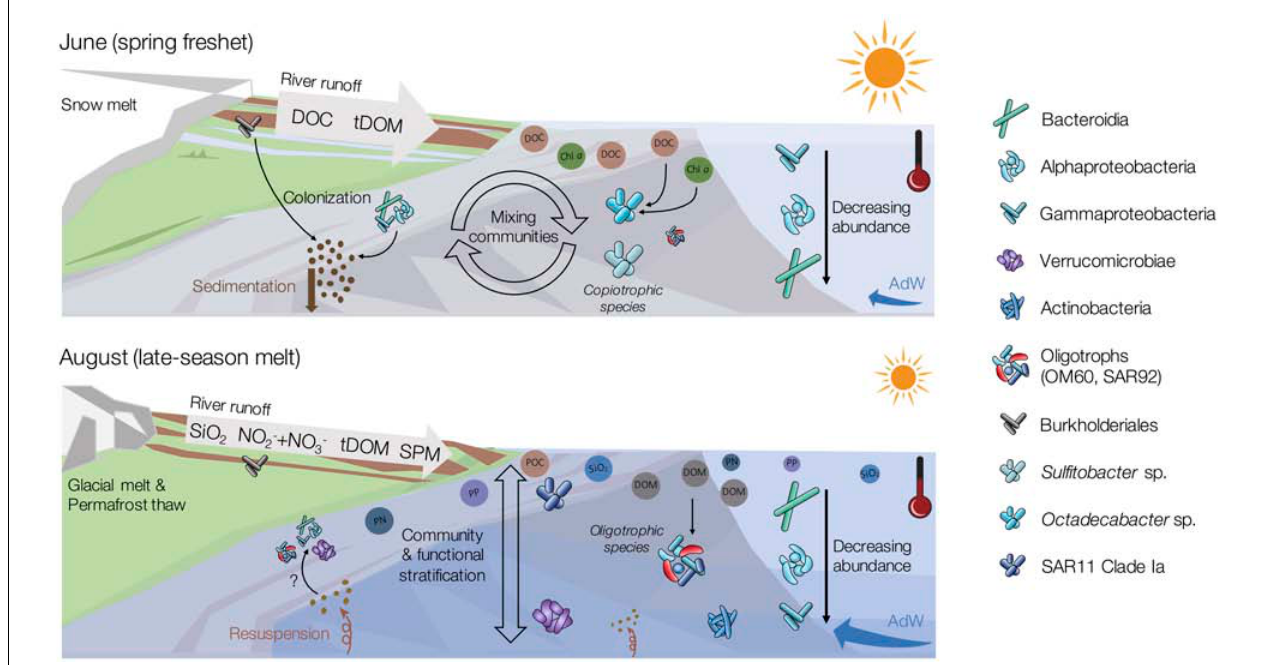
FIGURE 8 | Conceptual figure depicting major seasonal changes in the microbial communities in relation to changing physical and chemical variables between the early (June) and late (August) melt season. This figure includes components of conceptual figures presented by Kellogg et al. (2019); McGovern et al. (2020), and some symbols are modified after the Integration and Application Network (ian.umces.edu/symbols/). For detailed information on biogeochemistry of the system, see McGovern et al.